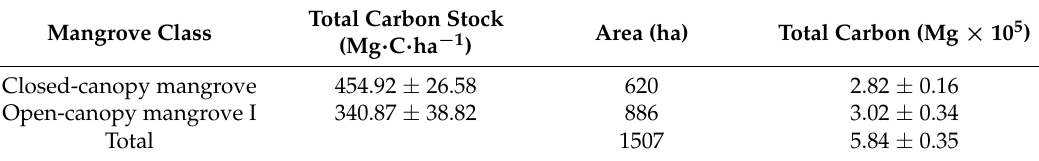
Table 5. Mean ± standard error and total carbon mass calculated for each height class and the resulting ecosystem C stock estimate for inventoried mangroves in Helodrano